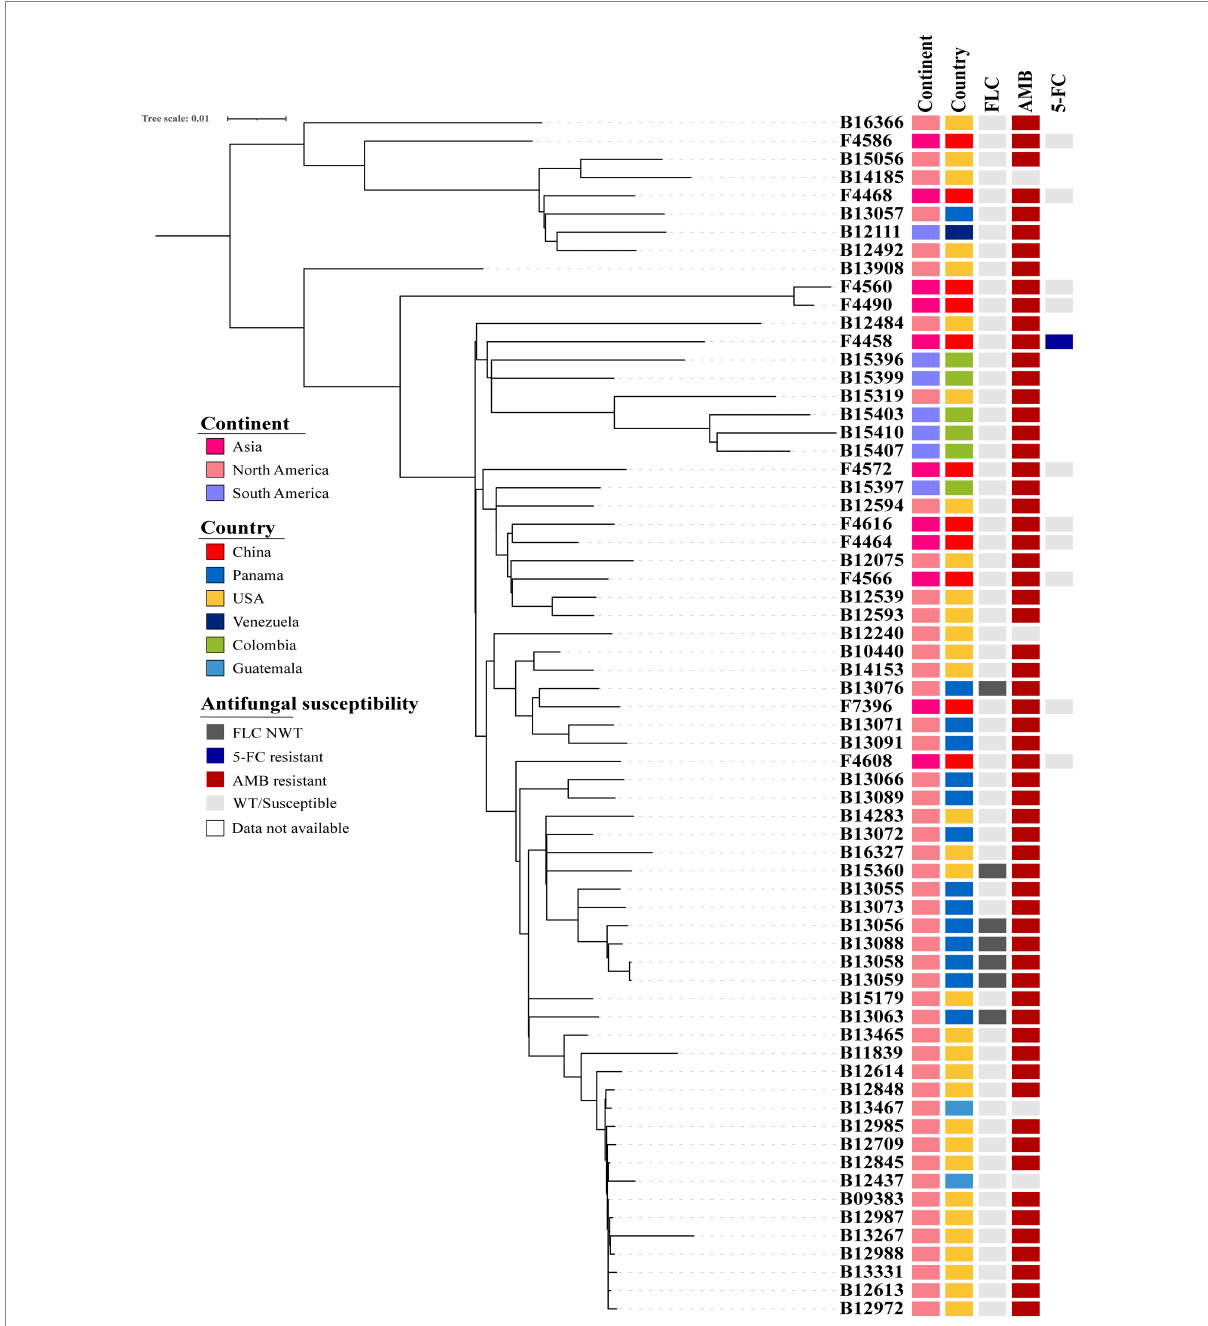
FIGURE 1 Phylogenetic tree of Candida duobushaemulonii . The phylogenetic tree was constructed with RAxML using the maximum likelihood method based on 8,117 SNPs. Phylogenetic tree detailing susceptibility to fluconazole (FLC), amphotericin B (AMB), and 5-flucytosine